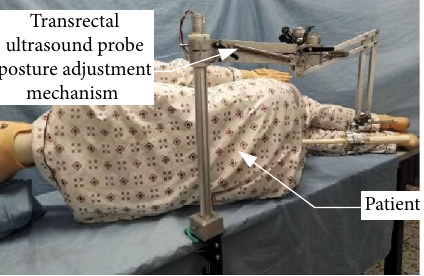
Figure 12: Physical prototype of the posture adjustment mechanism of ultrasonic